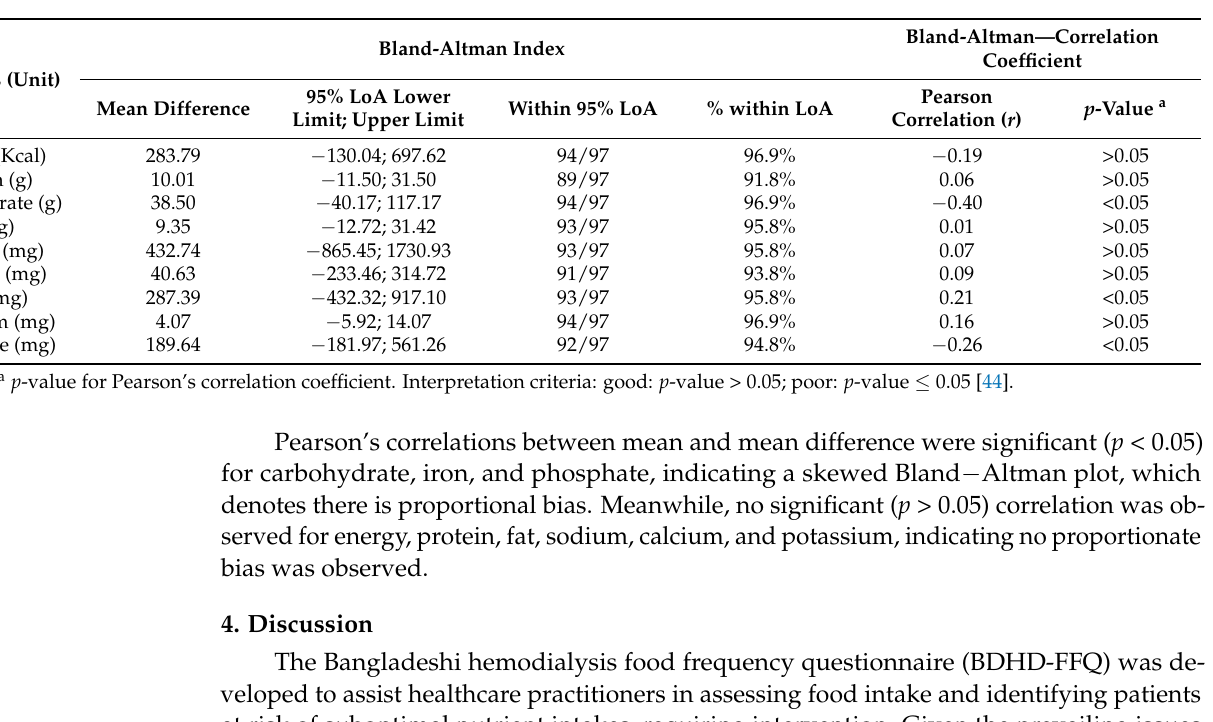
Figure 2. Bland-Altman plots visualizing the agreement between the BDHD-FFQ and 3DDRs. Bland-Altman plots picturing the agreement between the BDHD-FFQ and 3DDRs to evaluate the intake of ( a ) energy, ( b ) protein, ( c ) carbohydrate, ( d ) fat, ( e ) sodium, ( f ) calcium, ( g ) potassium, ( h ) iron and ( i ) phosphate. For all plots, the middle red line represents the mean differences between the BDHD-FFQ and 3DDRs, and limits of agreement (green line) show the 95% confidence interval (mean ± 1.96 SD). Table 7. Limit of agreement (LoA) and correlation between mean and mean differences.